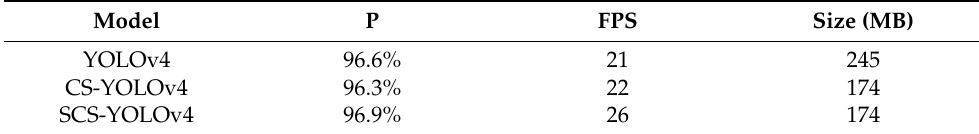
Table 2. Comparison of model performance after optimization (bar code).